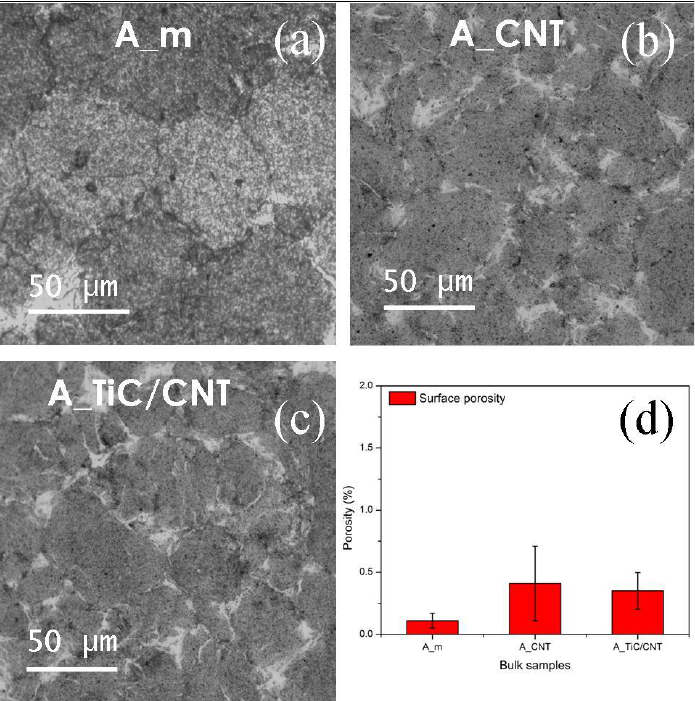
Figure 4. Optical images of the microstructure of bulk samples of matrix material ( a ), CNT-reinforced composite ( b ), TiC/CNT-reinforced composite ( c ) and surface porosity data of these samples ( d ).